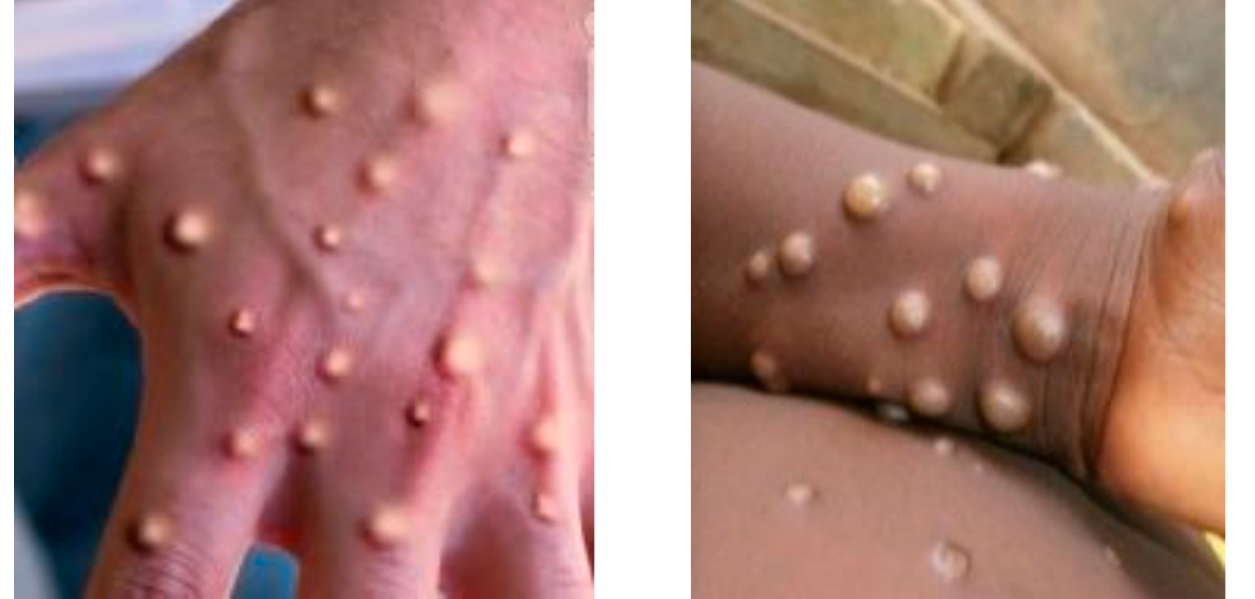
Figure 1. From left: lesion properties of monkeypox and Chickenpox [20,21].